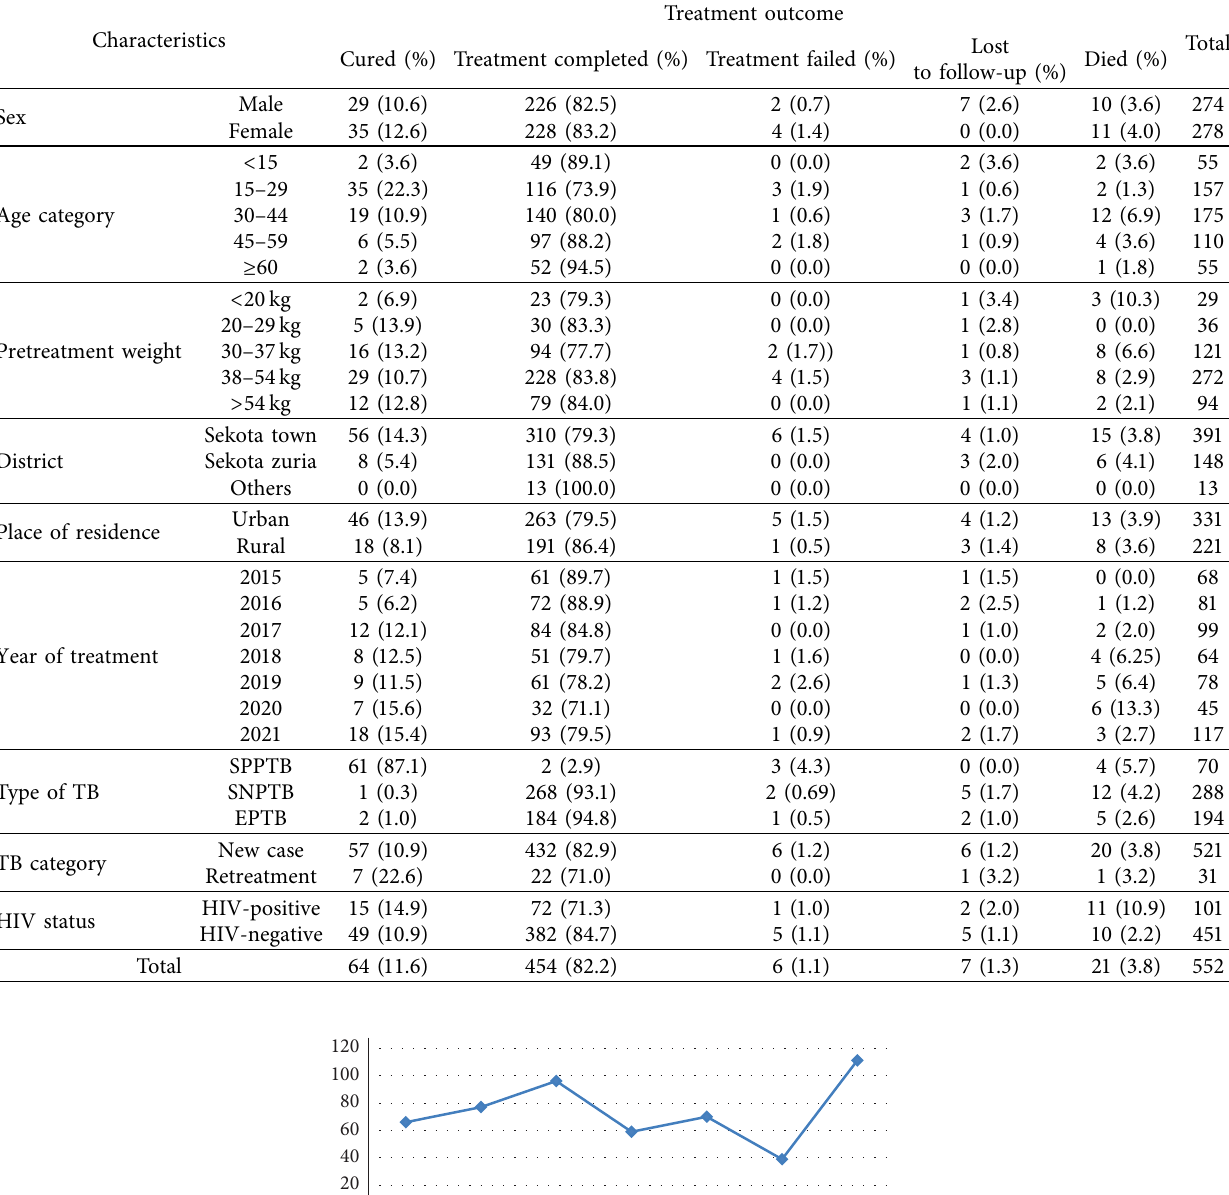
Treatment outcome